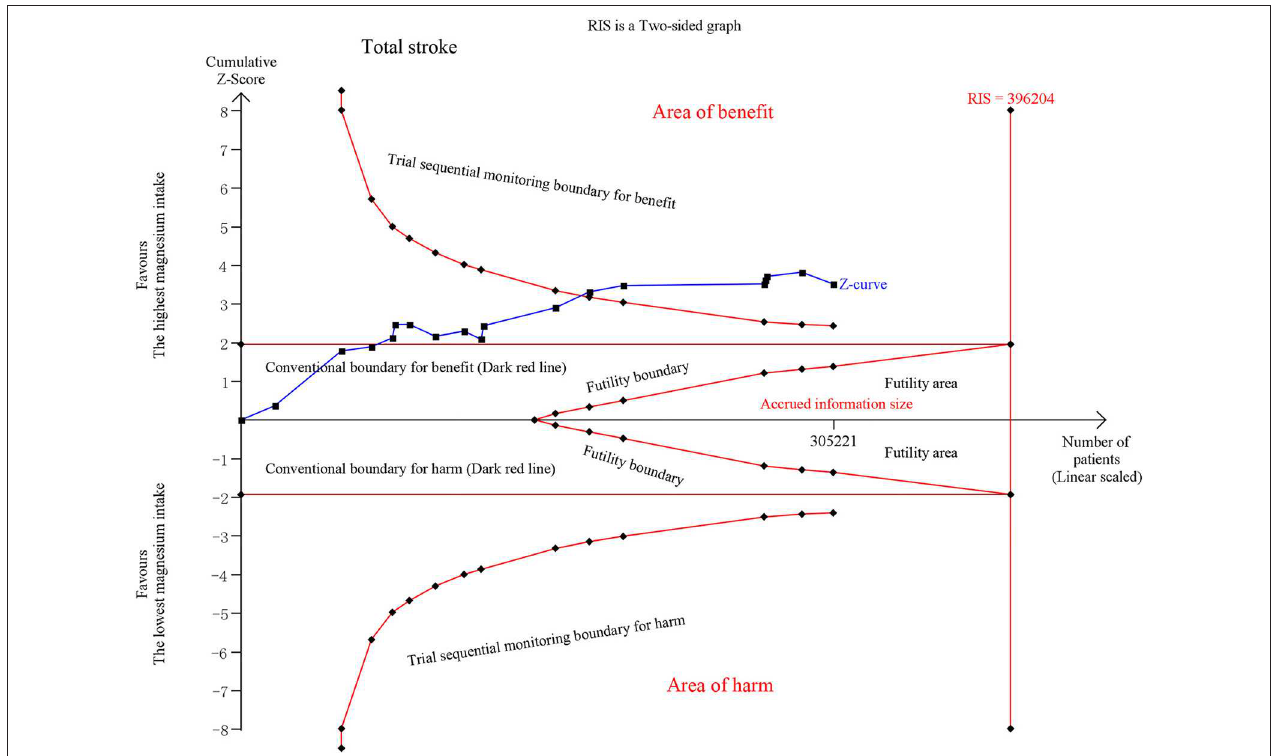
FIGURE 2 | Trial Sequential Analysis (TSA) of total stroke comparing the highest magnesium intake category to the lowest. The TSA illustrated that the cumulative Z-curve crossed both the conventional boundary for benefit and the trial sequential monitoring boundary for benefit, demonstrating that the results are robust and conclusive, and further studies are not required. A diversity required information size (RIS) of 396,204 was computed by α = 0.05 (two-sided); 80% statistical power, with a conservative relative risk reduction of 5%. X-axis, the number of patients; Y-axis, cumulative Z -score; Dark red lines, conventional boundaries (upper for benefit, Z -score = 1.96; lower for harm, Z -score = − 1.96; two-sided P = 0.05); Sloping red lines with black, filled circle icons, trial sequential monitoring boundaries (two sides, computed accordingly); Sloping blue line with black, filled circle icons, Z-curve; Vertical red full line, RIS computed accordingly; Upper conventional boundary for benefit, area of benefit; Lower conventional boundary for harm, area of harm; Middle area, futility area; Red lines with black, filled circle icons in the futility area, futility boundaries.